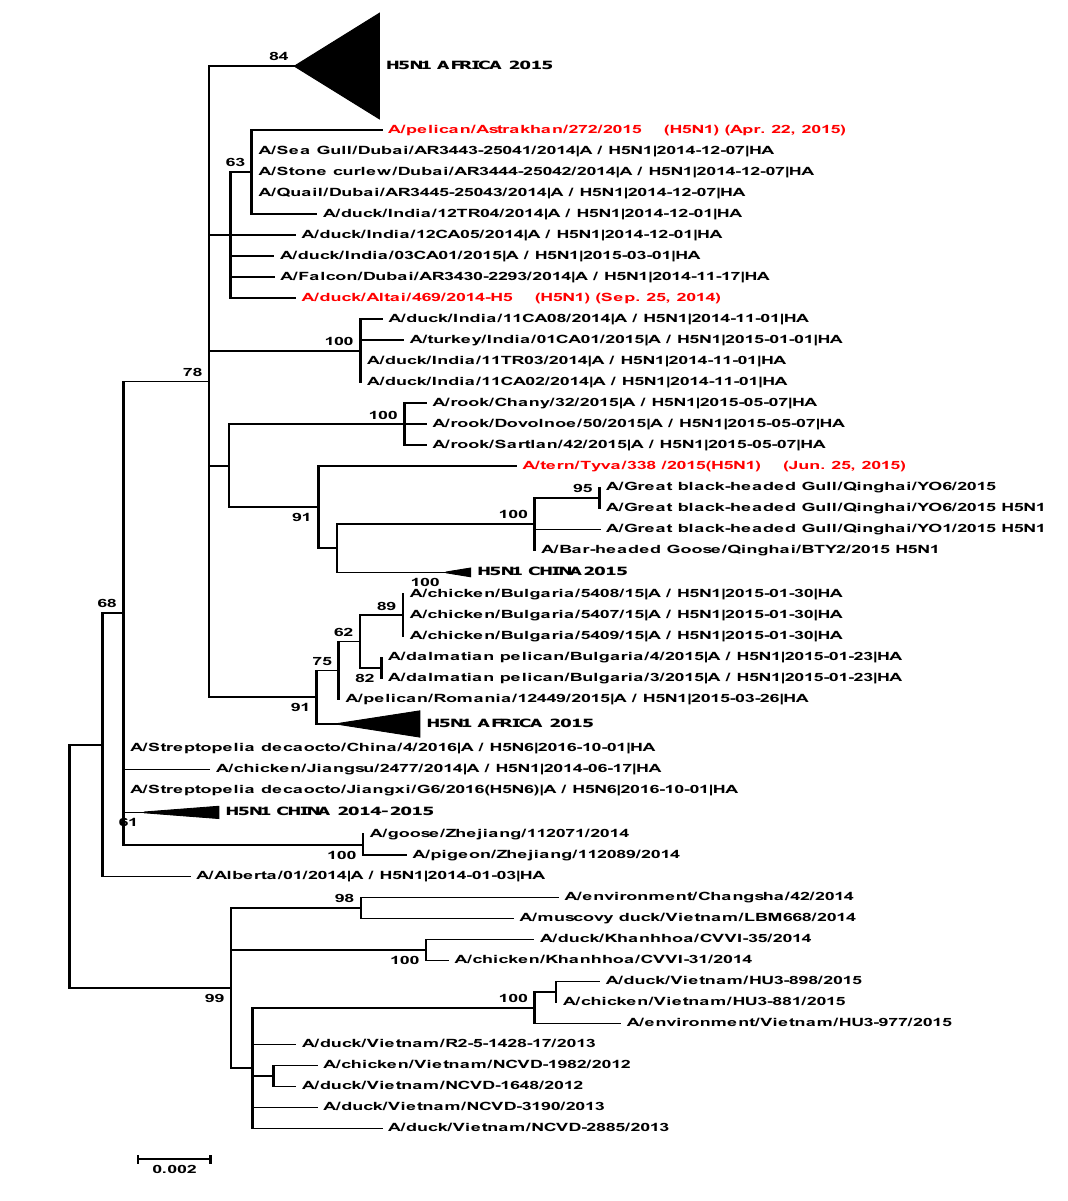
Figure 9. Phylogenetic tree constructed using the NJ method, based on the nucleotide sequence of the HA gene fragment (1–1704 bp ORF) of AIV subtype H5N1. H5N1 avian influenza viruses identified in the Russian Federation in 2014–2015 are marked in red.